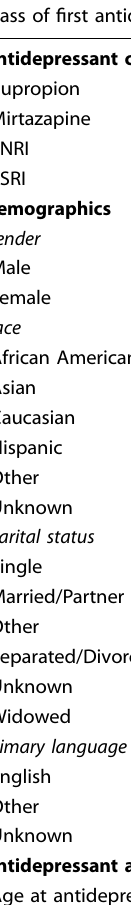
Table 1. Patient characteristics overall and by antidepressant